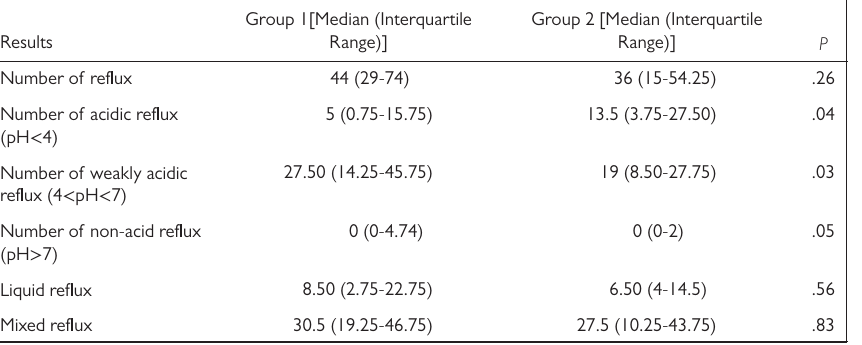
Table 5. Agreement of the Reflux Detection Ratio by MII-pH Monitoring or pH Monitoring of the Patients in Group